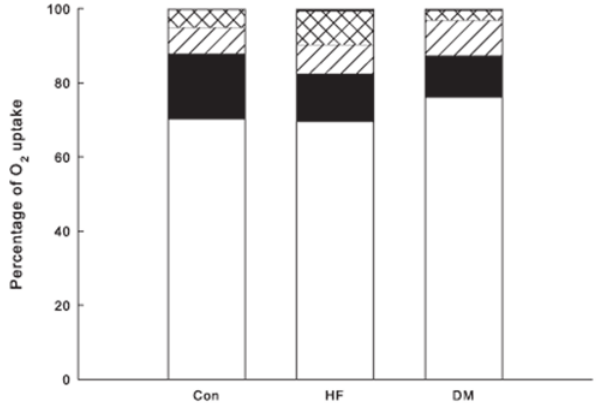
Figure 1. Contributions of different substrates to myocardial O 2 consumption. Oxygen extraction ratios were summed and adjusted to a total of 100%. Lower, white bar: sum of non-esterified fatty acids and triacylglycerol (i.e. fatty acid oxidation); solid black, glucose; diagonal hatched, lactate; cross-hatched, 3-hydroxybutyrate; think solid line at top, pyruvate. Con, control group; HF, heart failure group; DM, Type 2 diabetes group.